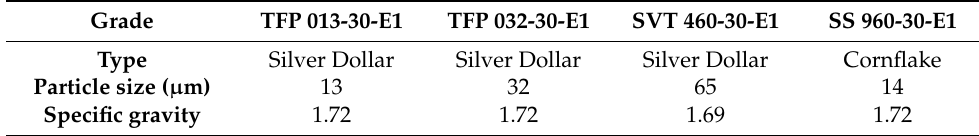
Table 1. Aluminum flakes of different shapes and sizes used in the